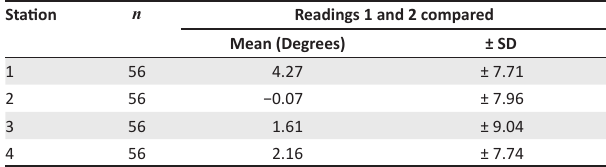
TABLE 2: Difference in means between readings by station. Station n